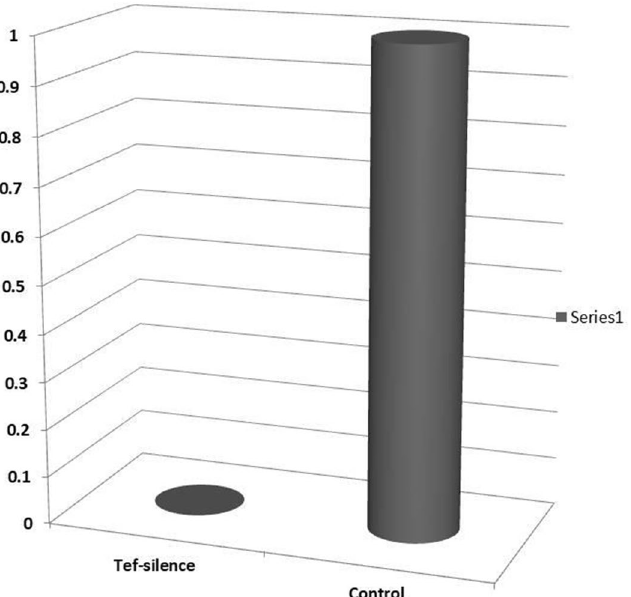
Figure 7. Comparative expression of Tef-1α in silenced and non-silenced L. theobromae using pFGC-TEF-d . Quantitative PCR showed a clear reduction of Tef-1α expression (518,134 fold) in silenced fungi using siRNA and hairpin structure of Tef-1α compare to the control